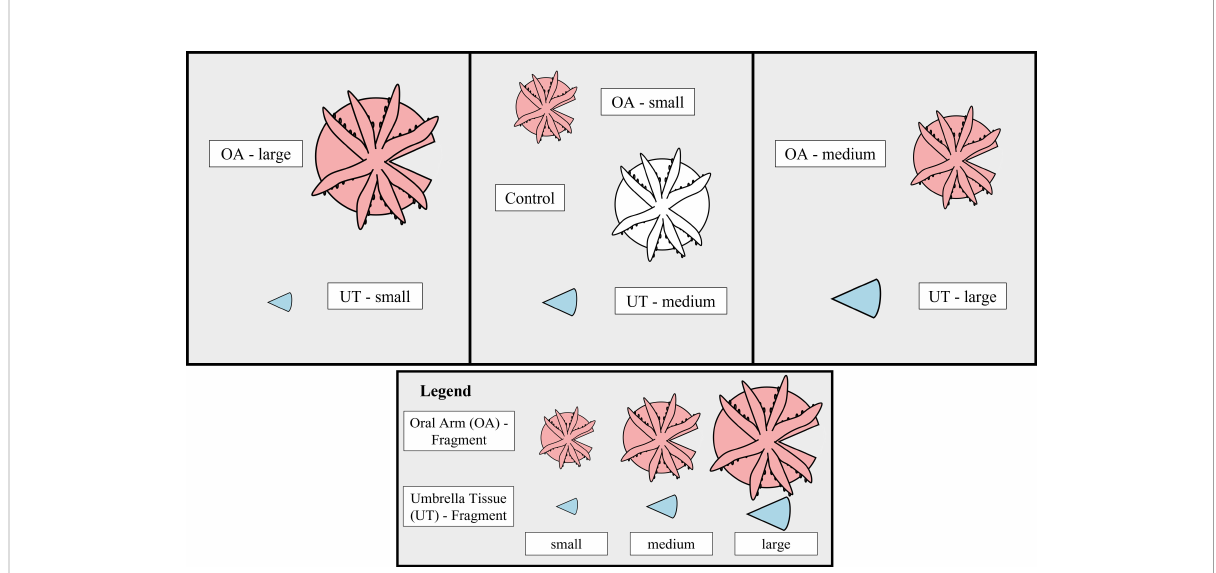
FIGURE 1 Experimental Design. Outline of the experimental design representing the distribution of the seven different groups (UT-small, UT-medium, UT- large, OA-small, OA-medium, OA-large, Control) within one aquarium. The fragment type is indicated by color (Oral Arm [OA] - fragment = red, Umbrella Tissue [UT] - fragment = blue, Control = white). Inside the aquarium two perforated plexiglass panels, indicated by black vertical lines, were used to better identify the fragments. In total, six aquaria were replicated using this